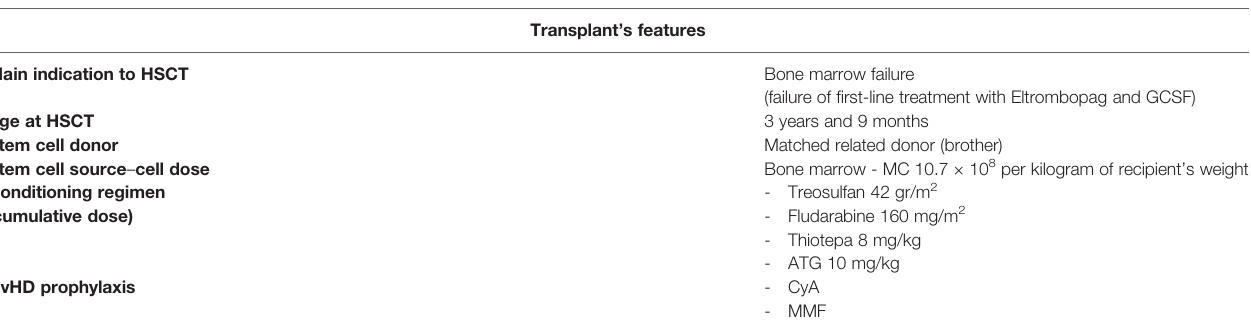
TABLE 2 | Hematopoietic stem cell transplantation (HSCT) features and related main complications of patient 2.